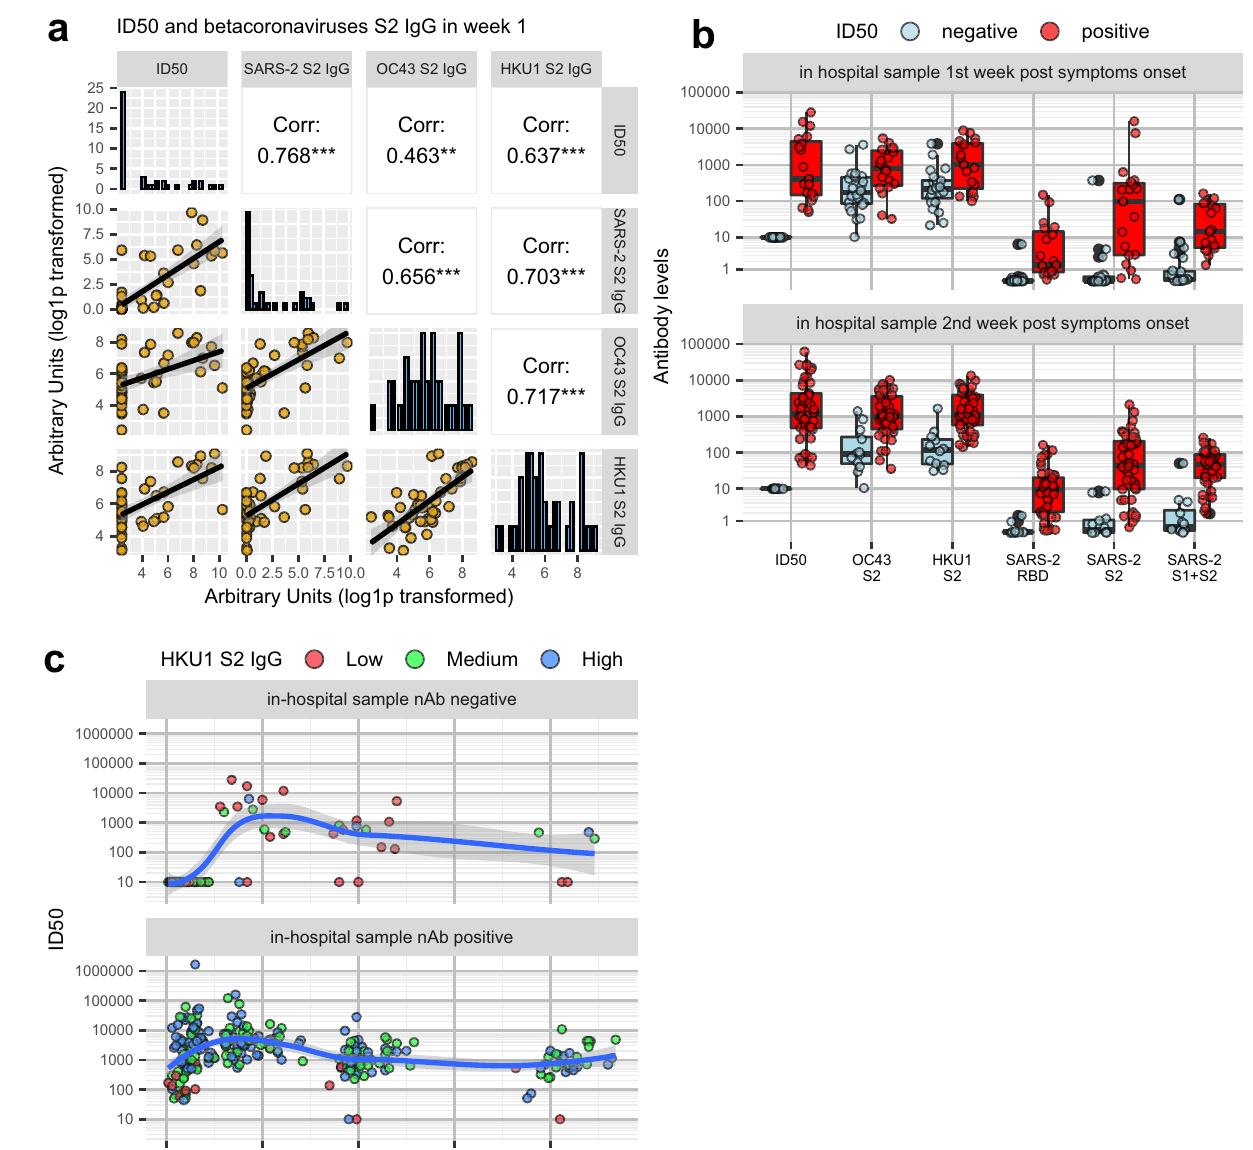
Fig. 6 NAbs and antibody (IgG) to S2 HCOV-OC43 and HKU1 and SARS-CoV-2. Sera of COVID-19 patients, collected at the indicated timepoint from symptoms onset, were measured by LV-based-neutralization assay and the LIPS to SARS-CoV-2 and HCoV S2 spike antigen as indicated. a Boxes under the diagonal show each correlation plot of the reciprocal of the ID50 and arbitrary units after log1p transformation. Dots correspond to individual measurements, the black line represents the regression line and the gray area its 95%CI. Boxes on the diagonal show as histograms the distribution of values in each assay. Boxes above the diagonal show the corresponding Pearson correlation analysis coef fi cients. Asterisks correspond to the following p values: *** p ≤ 0.001; ** p ≤ 0.01; * p ≤ 0.05. b Shown are box plot displaying median of each antibody response as indicated, IQR, and whiskers extending to 1.96 times the IQR, strati fi ed by sampling at the indicated week from symptoms onset and a negative or positive nAb response. c Development and kinetics of nAb responses to SARS-CoV-2 during follow-up of patients with negative or positive nAb score at the in-hospital sampling. Each colored dot corresponds to the reciprocal of the ID50 of a serum of a given infected individual strati fi ed for low, medium or high IgG to HCoV S2 antigens. Shown is the moving average of data + SE (black curve line + gray band) as obtained by a LOESS curve fi tting polynomial regression. Source data are provided as a Source Data fi